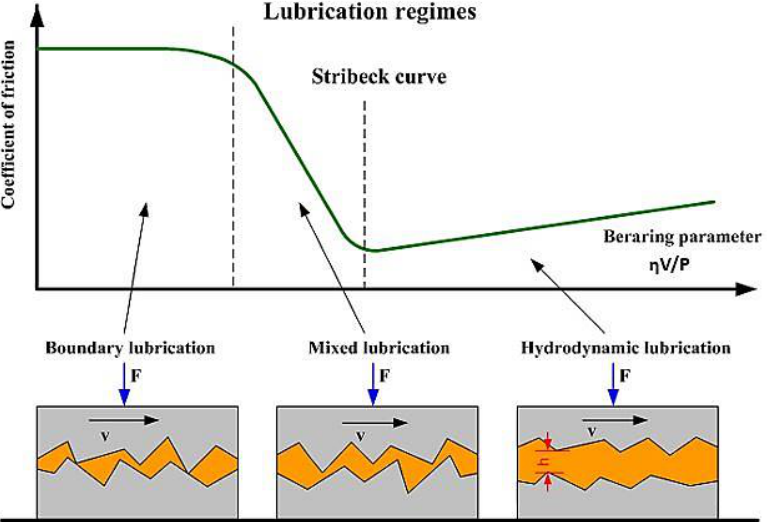
Figure 13. A Stribeck curve and illustrations of the lubrication regimes (Reprinted with permission from Nature, Copyrights 2016) [115].